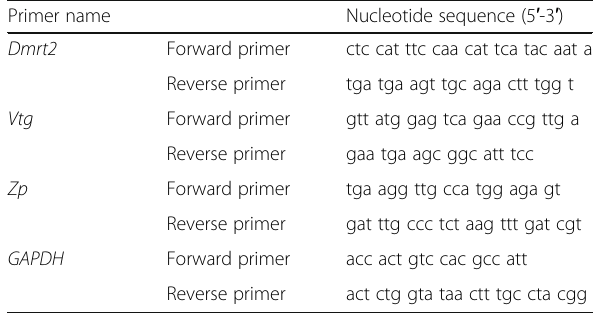
Table 1 Nucleotide sequence of primers used in RT-PCR